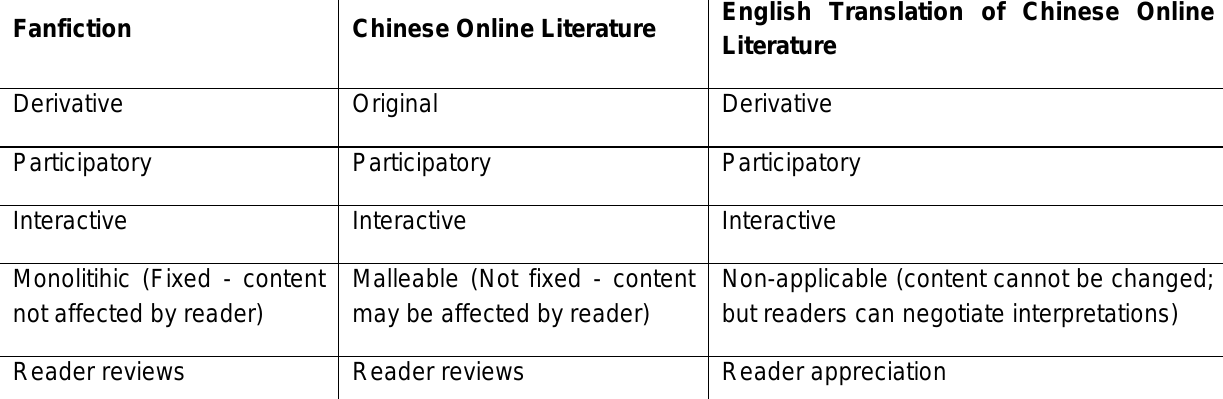
Table 1 | Comparison of fanfiction, Chinese online fiction, and fan translations of Chinese online fiction (adapted from Tian & Adorjan 2016, with addition).